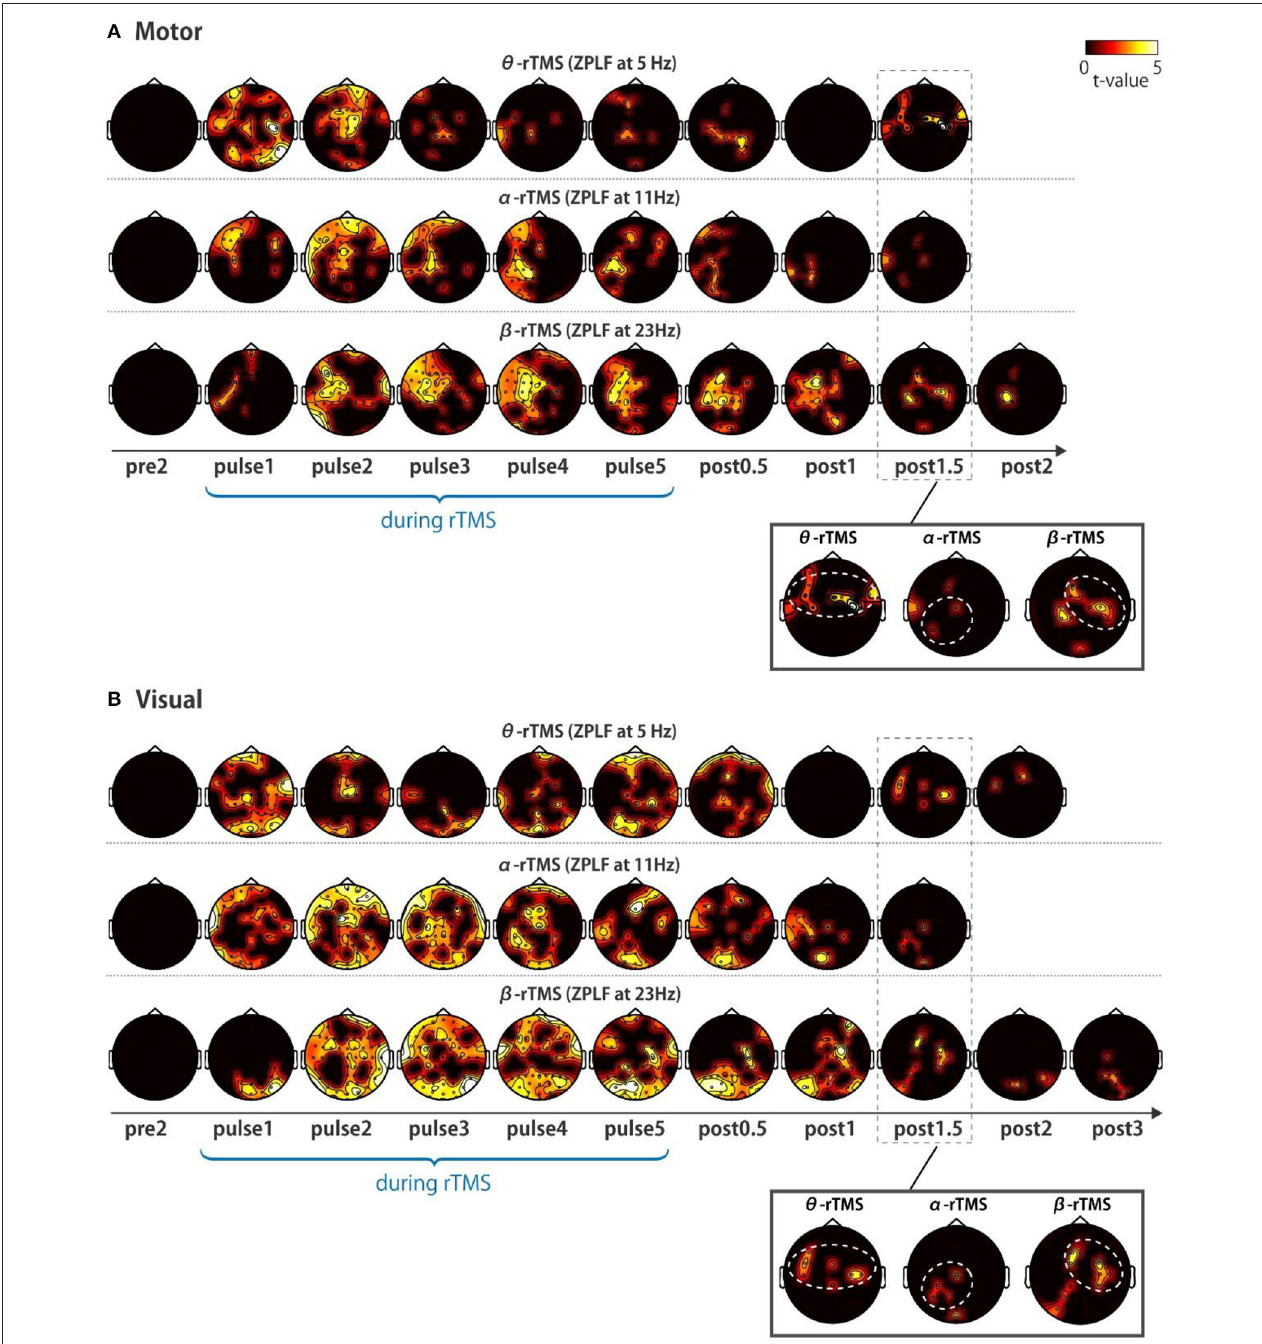
FIGURE 4 | Topographic representation of ZPLF. Each map with t -values from two cycles pre-stimulation (pre2) to post-stimulation (post2) indicates significantly larger ZPLF for the motor (A) , and for visual stimulation (B) than under the sham condition ( p < 0.05). The phase-locking of theta frequency oscillations in the frontoparietal, alpha frequency in the left occipitoparietal and beta frequency in the right motor areas are highlighted with white dotted circles in the magnified view of post 1.5 cycles.